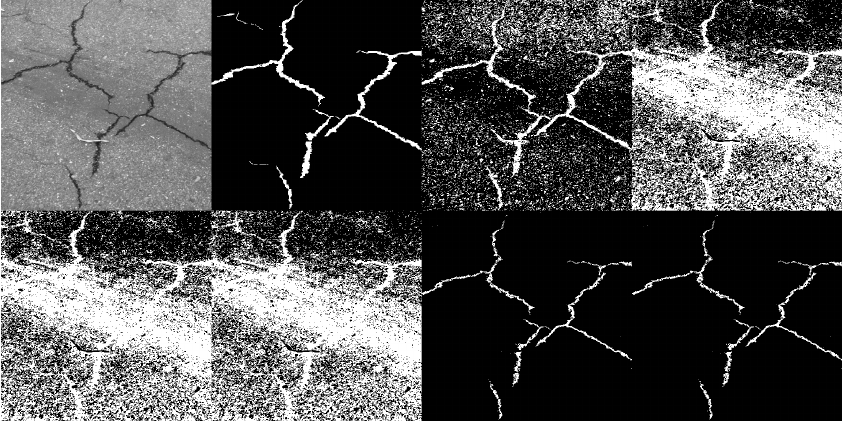
Figure 4. Segmentation of crack images with different clustering algorithms. First row: gray-scale image; true segmentation; GMM; KMEANS. Second row: FCMEANS; OTSU; ENT; DEMP.